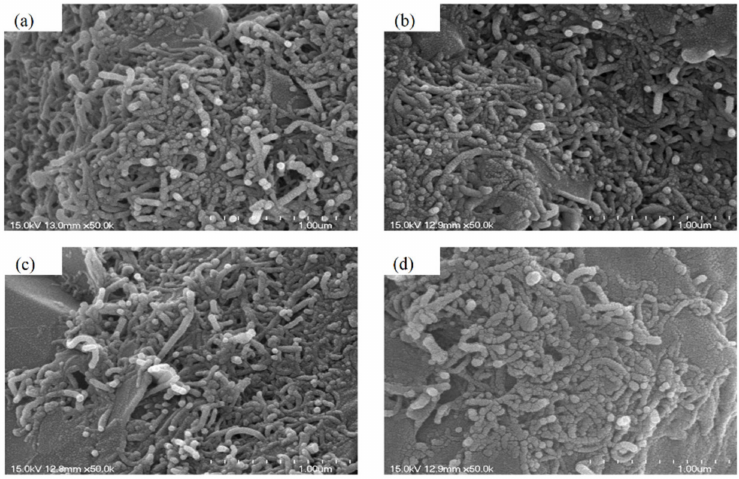
Figure 15. SEM images of the PTC-SHT after an applied voltage of 5 V for ( a ) 24, ( b ) 48, ( c ) 96, and ( d ) 240 h after 40,000 stretching–contraction